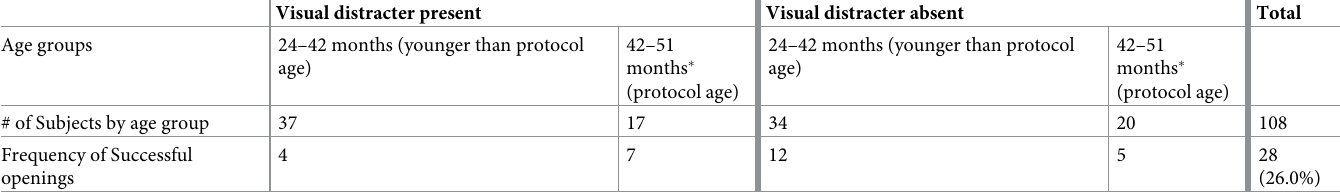
Table 3. Observed frequency of successful opening by age group for vials outfitted with or without visual distracters. Visual distracter present Visual distracter absent Age